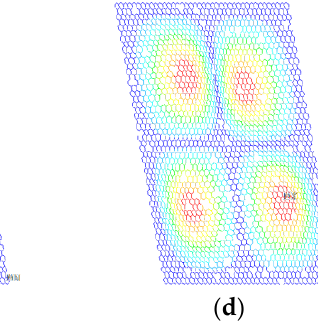
Figure 6. Displacement vector sums of porous graphene ( a – d ) for the first- to fourth-order vibration modes, respectively; the percentage of atomic vacancy defects is 1.5%.